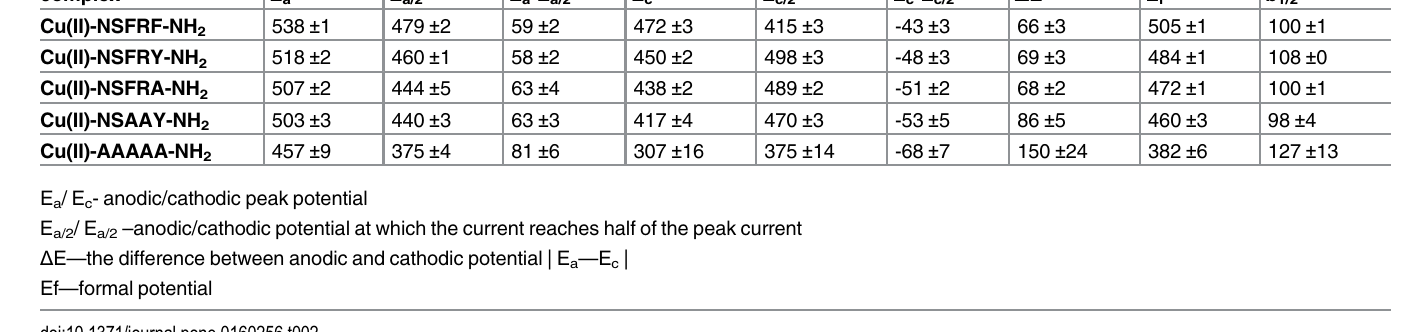
Table 2. Potentials and peak width (calculated from CV curves), b 1/2 -peak width at half height from (calculated from DPV curves) for particular Cu (II)-peptide complexes. All values were given in [mV].